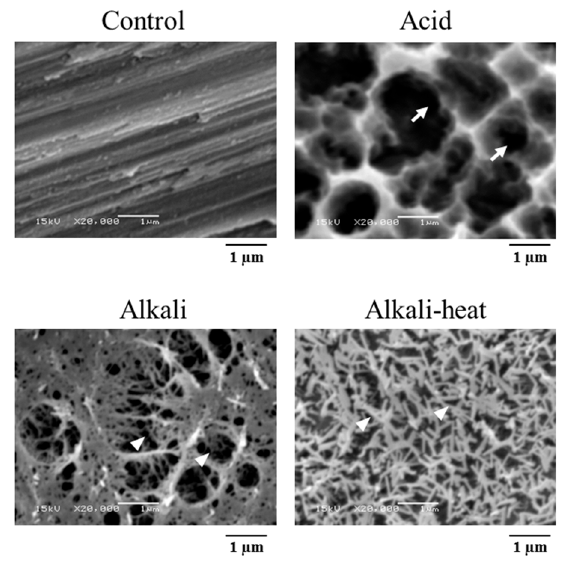
Figure 6. SEM images of the surface-treated MDF-Ti screw-type implants.